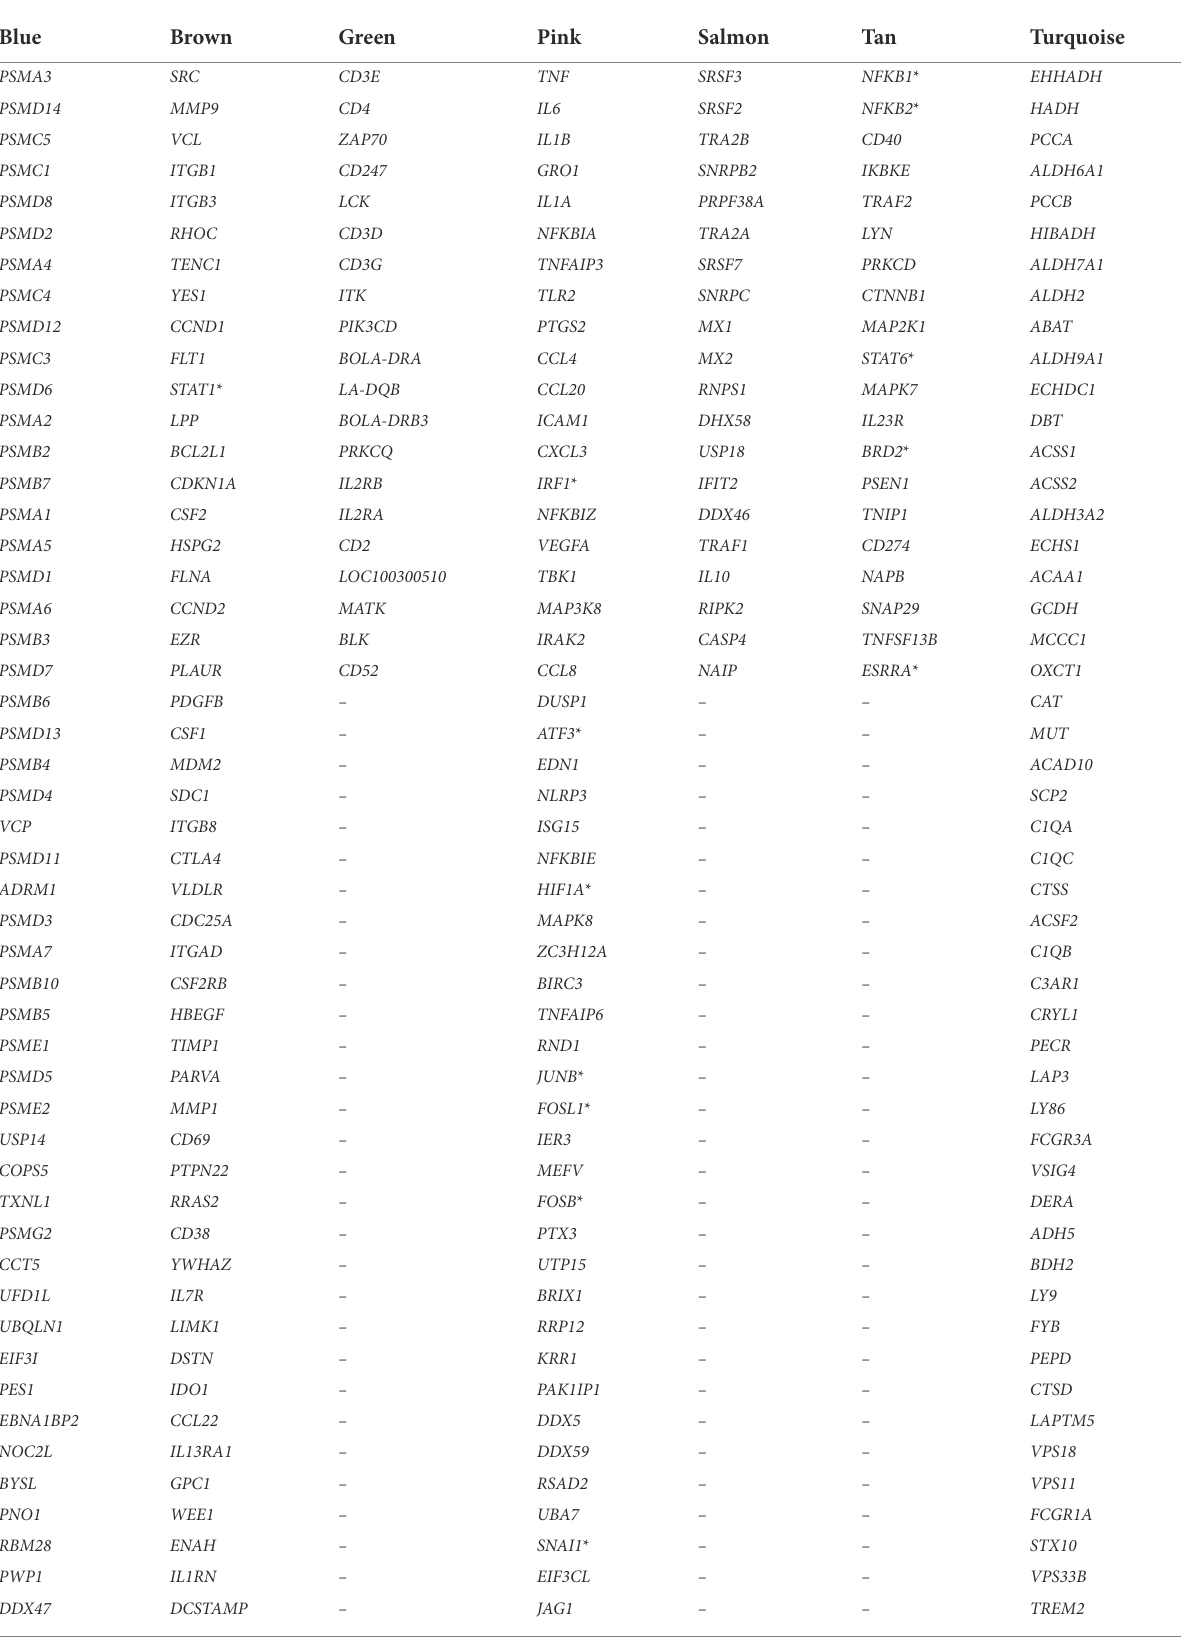
TABLE 1 List of the hub-central genes/TFs identified in the bTB-specific non-preserved modules. Module Blue Brown Green Pink Salmon Tan